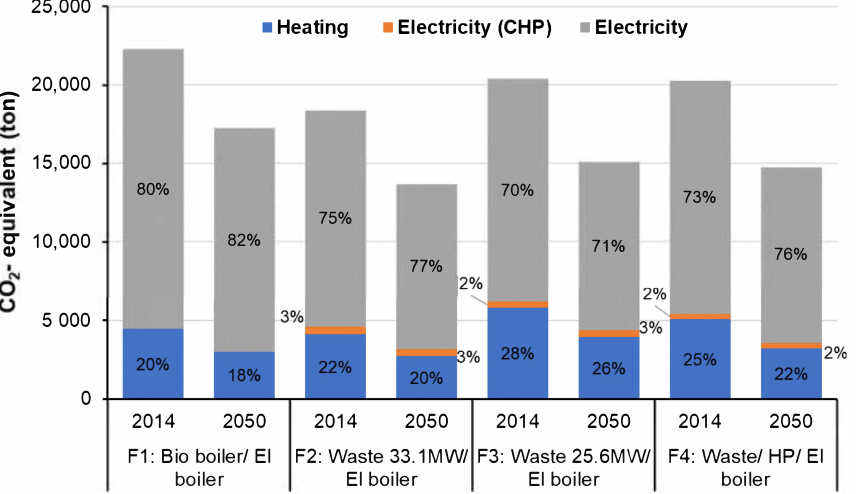
Figure 11. Allocation of the CO 2 emissions for the different energy supply technologies for the constant building stock.